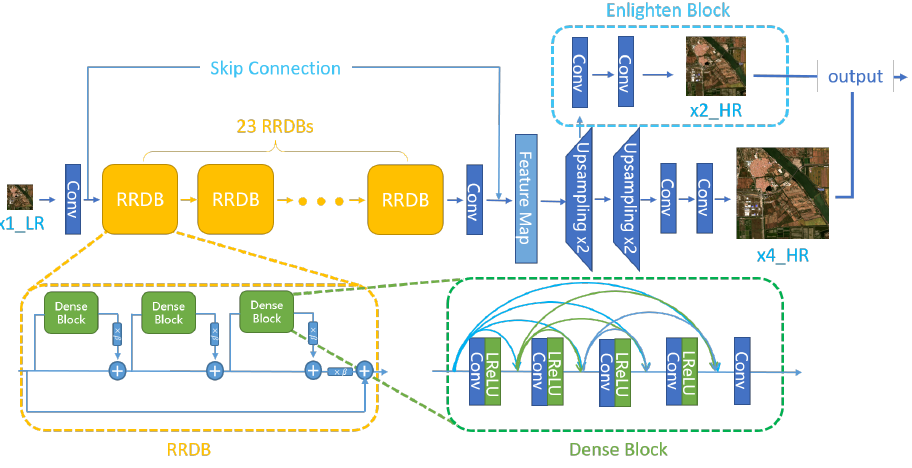
Figure 3. The architecture of the G. The bottom of network extracts feature maps by recursive learning and residual learning, while the top exploits these feature maps to predict multi-level HR images. The “Conv” refers to a convolutional layer with a 3 × 3 size kernels, while the RRDB means Residual-in-Residual Dense Block for short. The β in RRDB is the residual scaling parameter, which is set as 0.2.